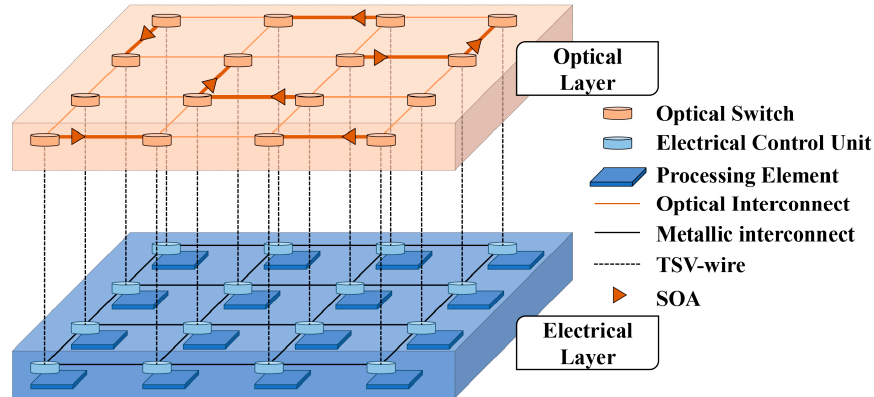
Figure 2. Semiconductor optical amplifier (SOA)-enabled HONoC